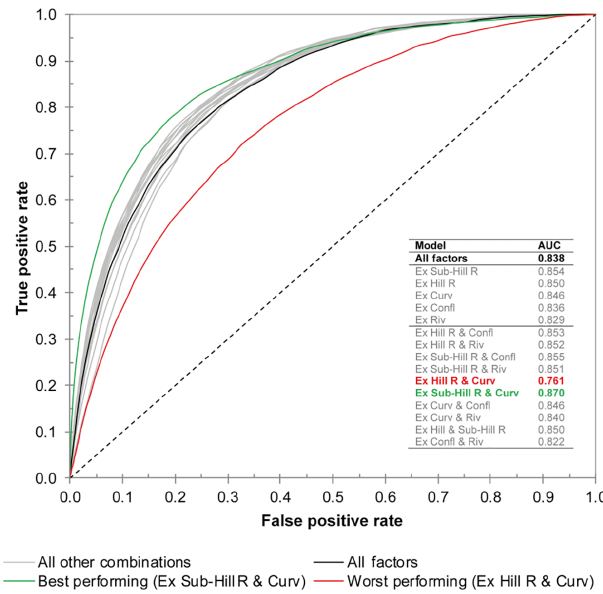
Figure 5. ROC curves for various different combinations of pre- disposing factors calculated from the test landslides ( n = 4312) mapped by the joint ICIMOD–NASA–UA group up to 2 June 2015. Black line in plot and black text in legend show the model with all factors; green shows the best performing combination; red shows the worst performing combination; grey shows all other combina- tions. Ex – excluding; Sub-Hill R – sub-hillslope relief; Hill R – hillslope relief; Curv – planform curvature; Confl – distance to con- fluences; Riv – distance to